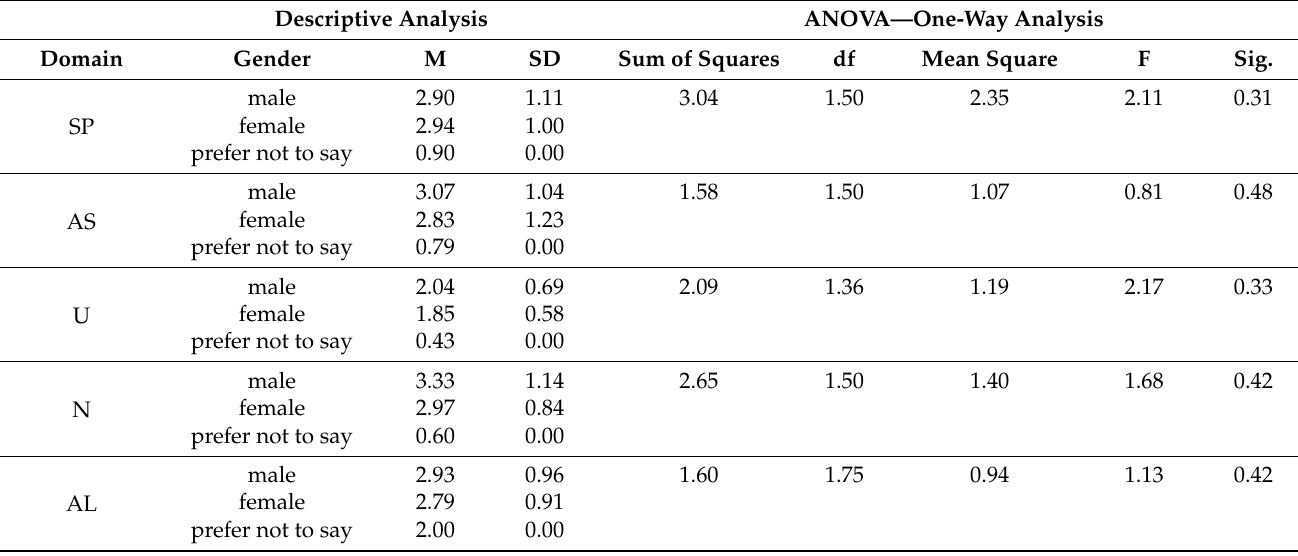
Table 3. Descriptive and one-way analysis of toxic leadership domains and gender.